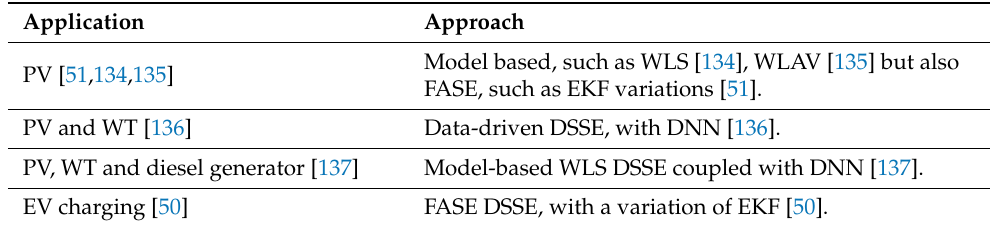
Table 6. Applications of DSSE